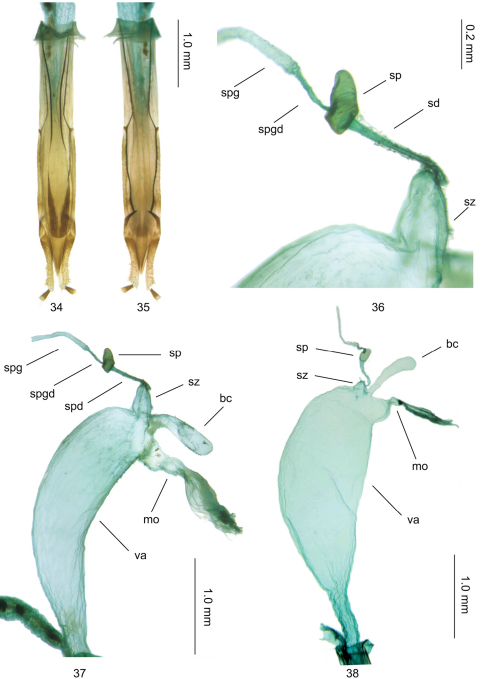
Female reproductive organs. 34–37 Tillicera auratofasciata from Yunnan 34 ovipositor, dorsal view 35 ovipositor, ventral view 36 spermatheca 37 internal organs in lateral view 38 Tillicera sensibilis from Yunnan. Abbreviations: bc = bursa copulatrix; mo = median oviduct; sp = spermatheca; sz = swollen zone; spd = spermathecal duct; spg = spermathecal gland; spgd= spermathecal gland duct; va = vagina.